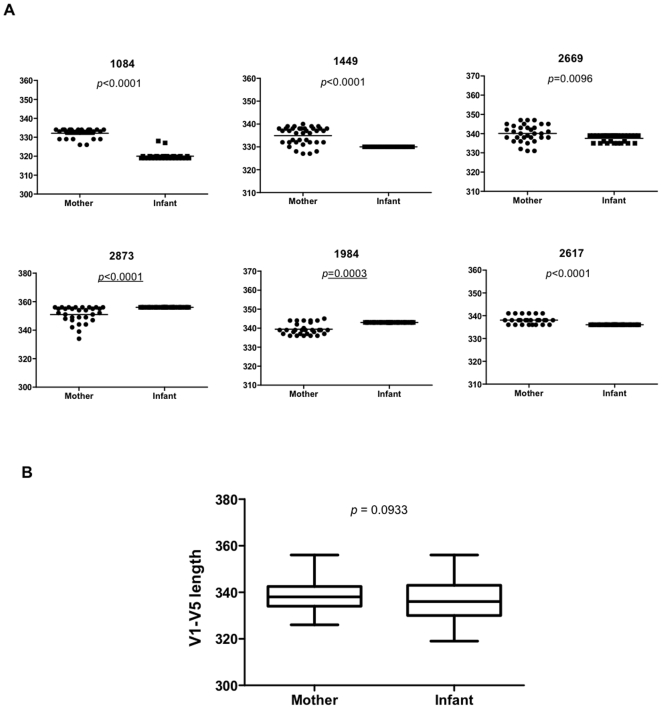
Comparison of Env V1-V5 length between mother and infant variants.(A) Comparison of Env V1-V5 length for each transmission pair. The P value for each comparison between the mother and infant are shown. The horizontal bars indicate the mean value for each individual. (B) Comparison of Env V1-V5 length of the aggregate sequences from mothers and infants. The P value for the comparison between the mother and infant is shown. The box and whiskers plot denotes the median, minimum and maximum values.